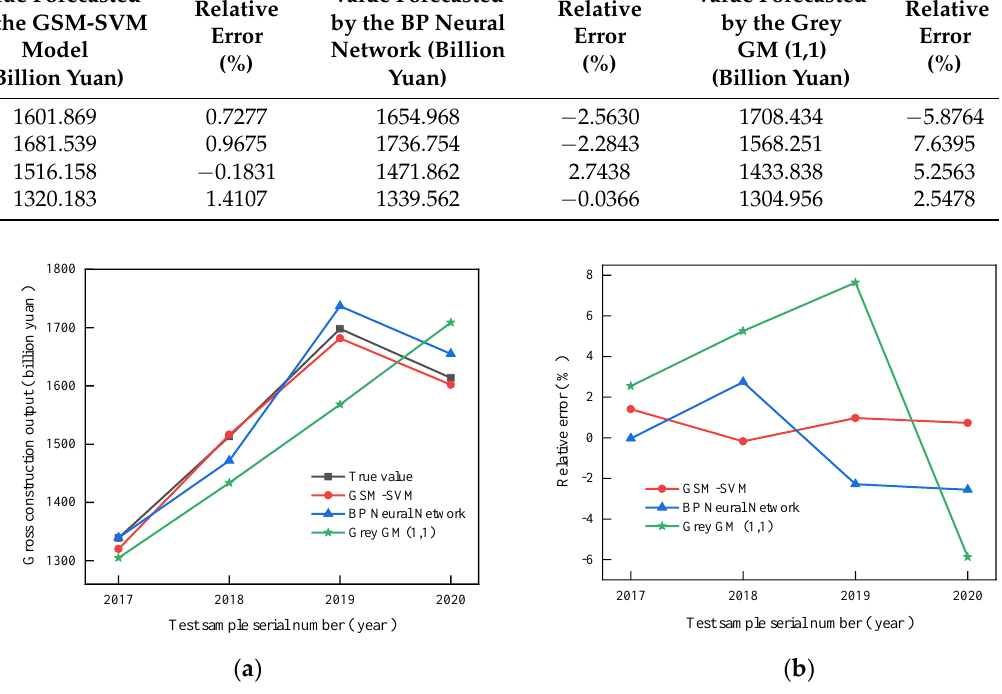
Figure 5. Comparison of the predictive performance of the three models. ( a ) forecast values and targets for the gross output of construction, ( b ) relative error diagram. Table 4. Comparison between the gross output forecasted by the three models and the actual value of the construction industry.